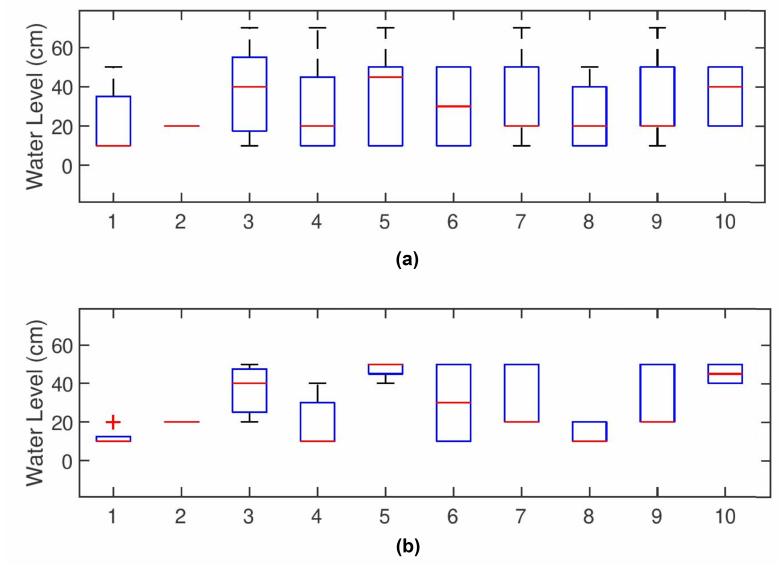
Figure 7. The variance of water level measurements ( a ) before and ( b ) after the sigma